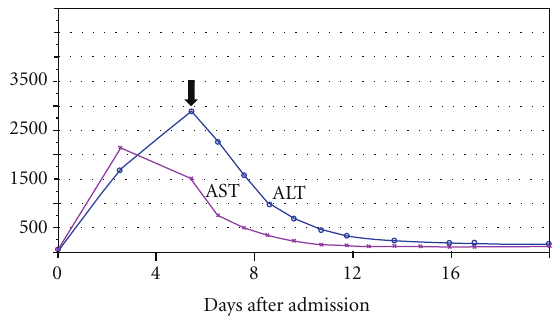
Figure 2: Trend of the liver enzymes (IU/L) after repair of the ACF